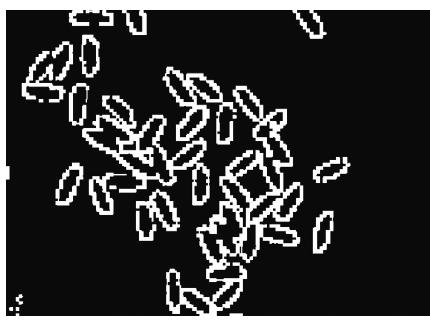
Figure 23: The classic range-transformation watershed